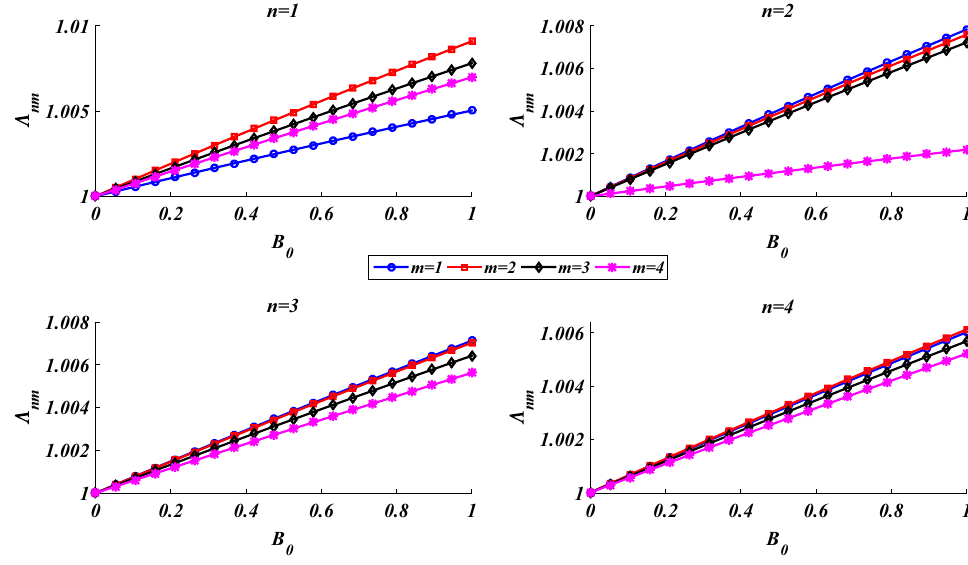
Figure 7. Dependency of the natural frequencies on the compressibility of the pore